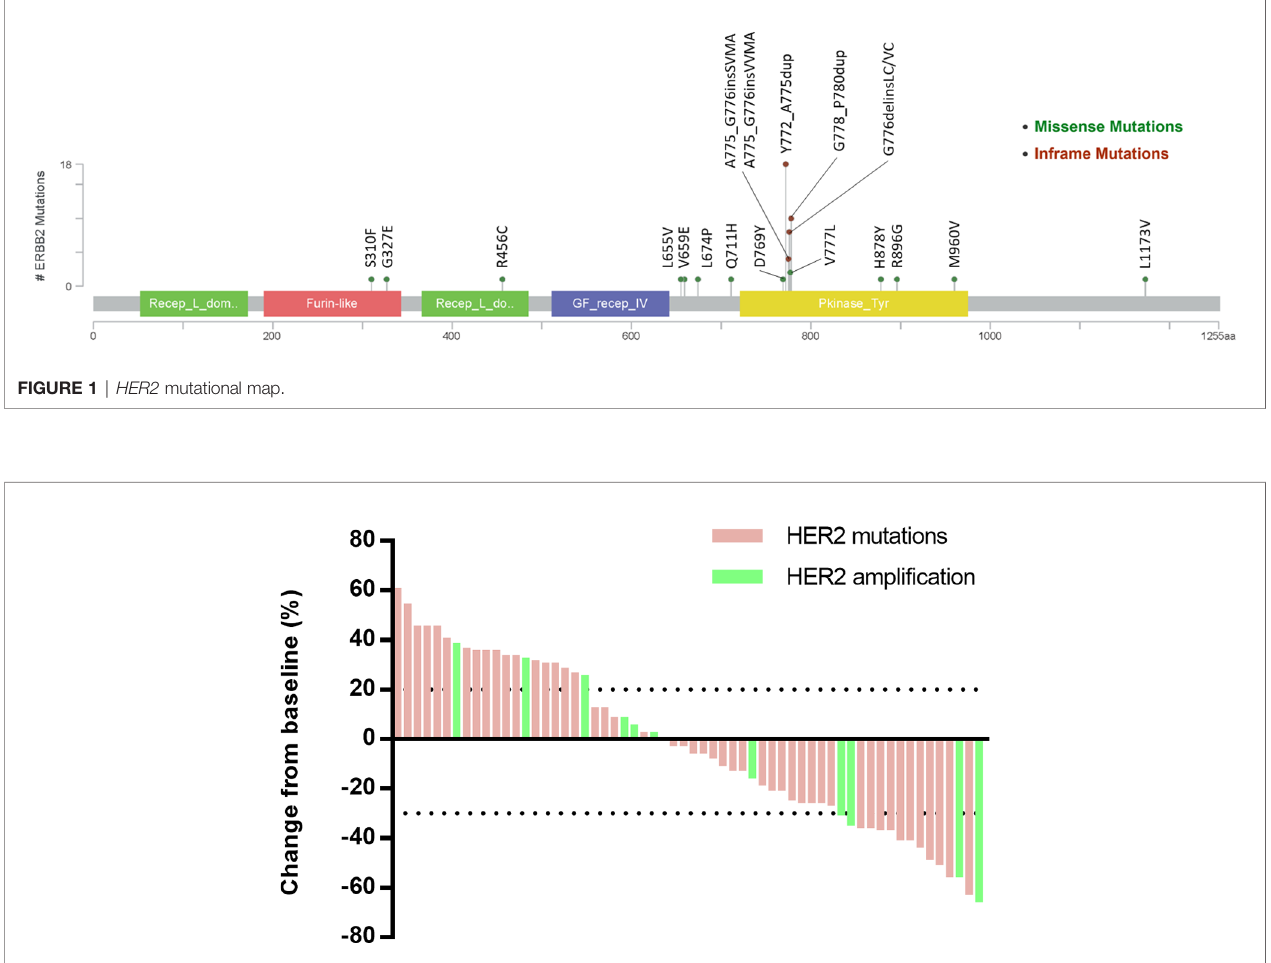
FIGURE 2 | Maximum percentage change from baseline in target lesions.